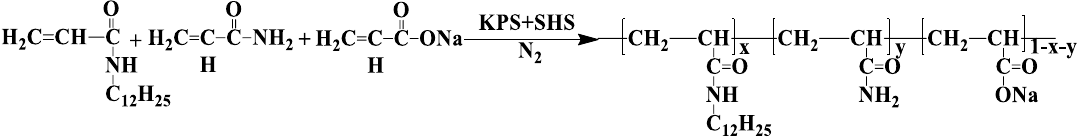
Figure 1. Synthesis of P(acrylamide (AM)–sodium acrylate (NaA)– N -dodecylacrylamide (DDAM)). KPS—potassium persulfate.